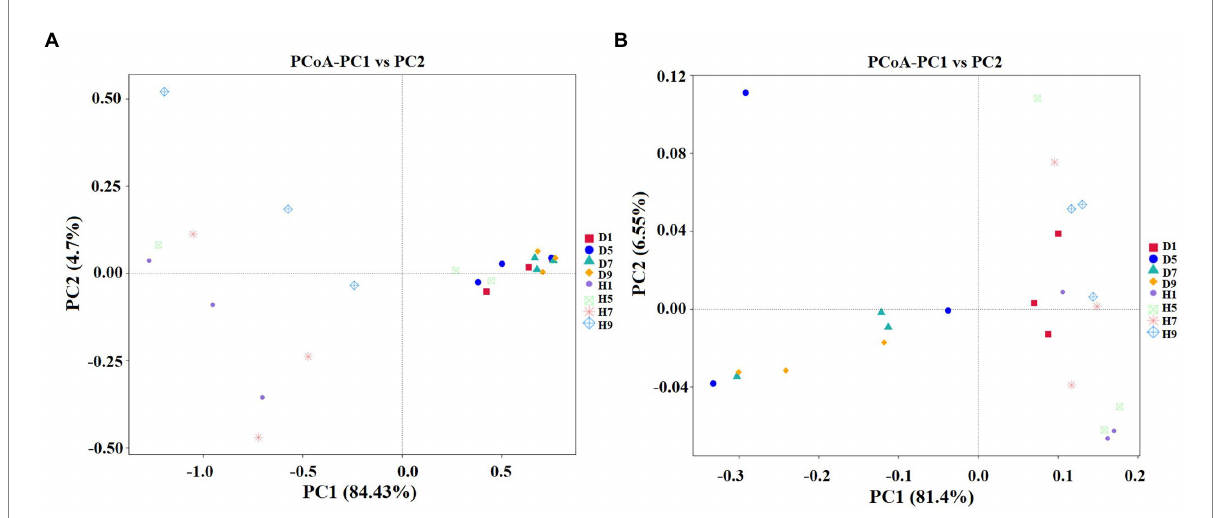
FIGURE 6 Principal Co-ordinate Analysis (PCoA) of the fungal (A) and bacterial (B) communities in the different group sample.